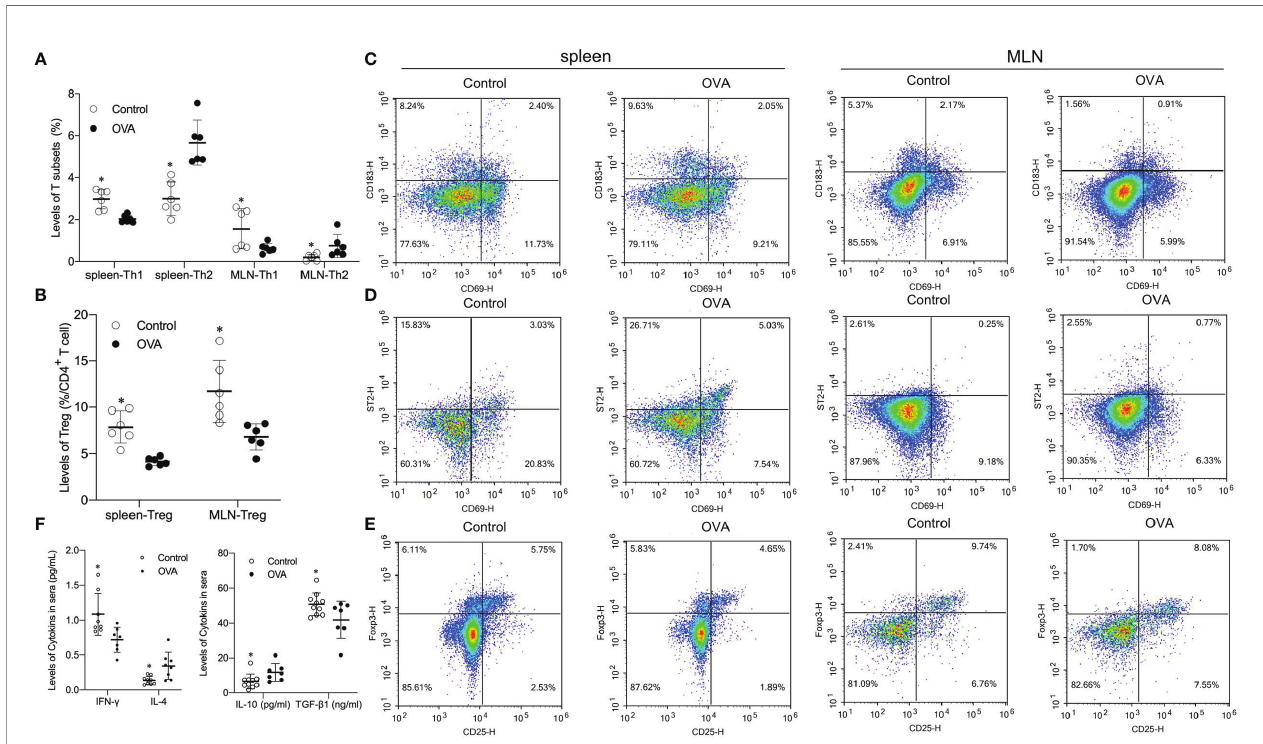
FIGURE 3 | Splenic and MLN levels of Th1, Th2, Foxp3 + T regulatory (Treg) populations and concentrations of related cytokines in two groups. The bar in the graph denotes Mean and SD. n=6-12/group. *p ≤ 0.05 vs OVA-treated group; Statistical analyses were performed with two-tailed Student ’ s test. (A) Percentage of T subsets (Th1, Th2) in spleen and MLN. (B) Percentage of Treg in CD4+ T cell in spleen and MLN. (C – E) Representative images showing Th1, Th2 and Foxp3 + Treg levels in speen and MLN. (F) Level of cytokines (INF- g , IL-4, IL-10 and TGF- b 1) in sera of